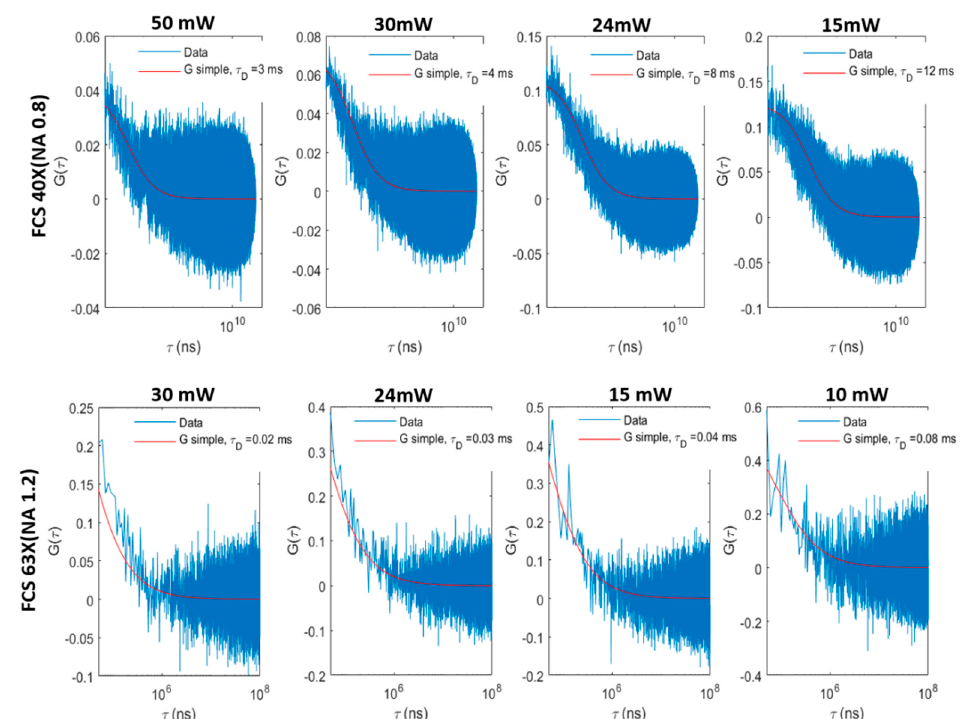
Figure 7. The effect of excitation power on FCS data obtained for Rhodamine B solution. Autocorrelation function data (blue) and fitted data (red) are shown. The data was obtained from red channel (580/150 nm) when excited at 800 nm wavelength using 40× (NA 0.8) and 63× (NA 1.2) objective lenses.